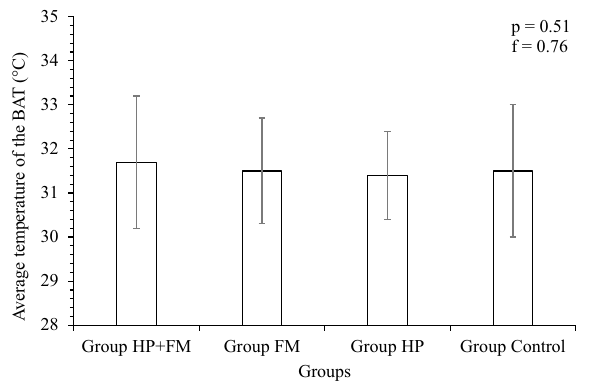
Figure 5. Average BAT temperatures for Group HP + FM, Group FM, Group HP and Group